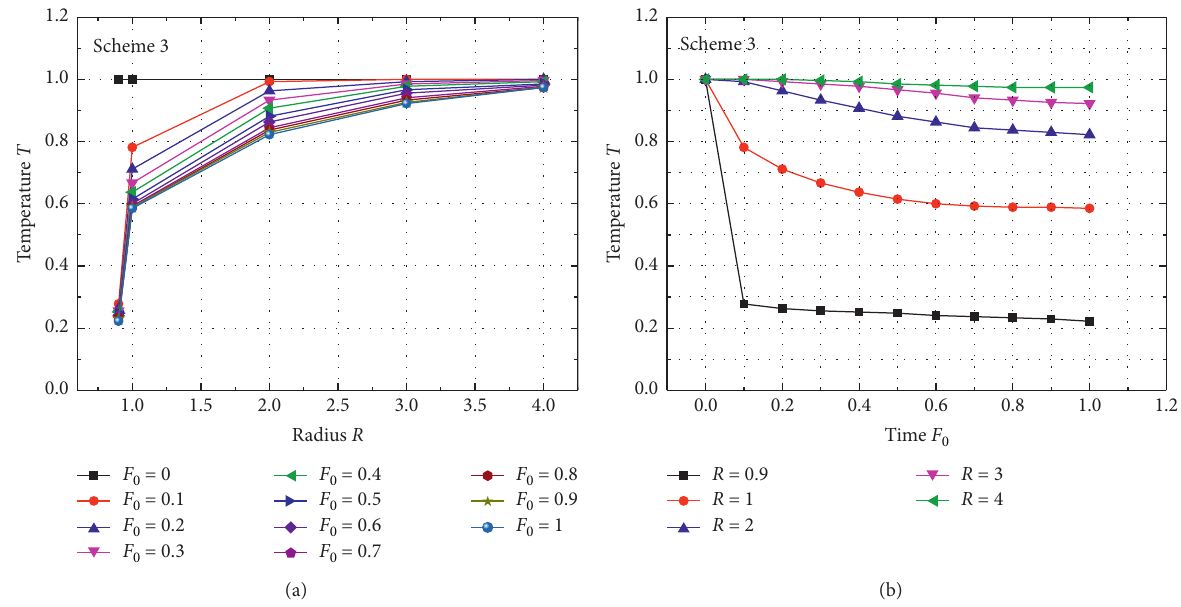
Figure 8: T − R curve and T − F